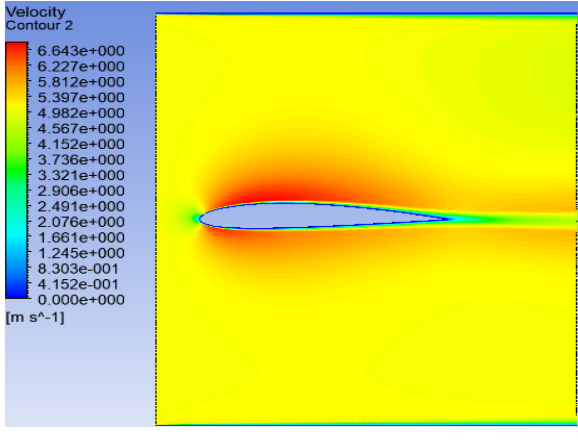
Figure 9. Velocity variation of NACA2415